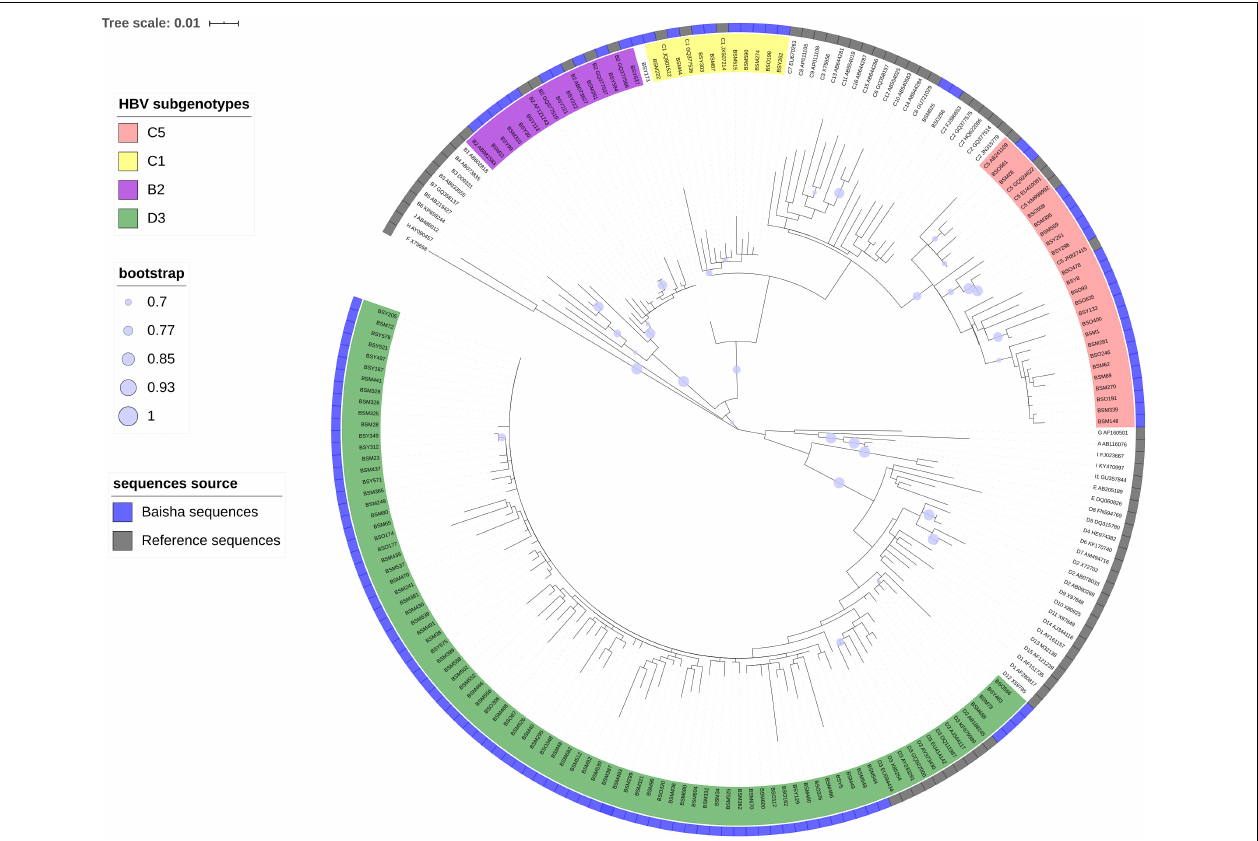
FIGURE 1 | Estimated maximum-likelihood phylogeny for Baisha’s Li ethnic partial P region sequences. The sequences identified in this study are shown in a blue strip. Reference sequences were named by subgenotype, and accession numbers represent the assigned HBV genotypes and